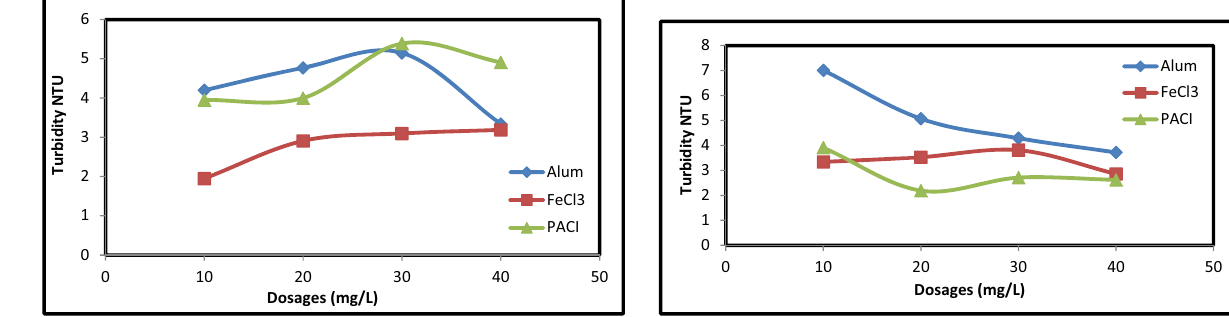
Figure 15: The relation between coagulants and fi nal residual tur - bidity for samples at 180 cm